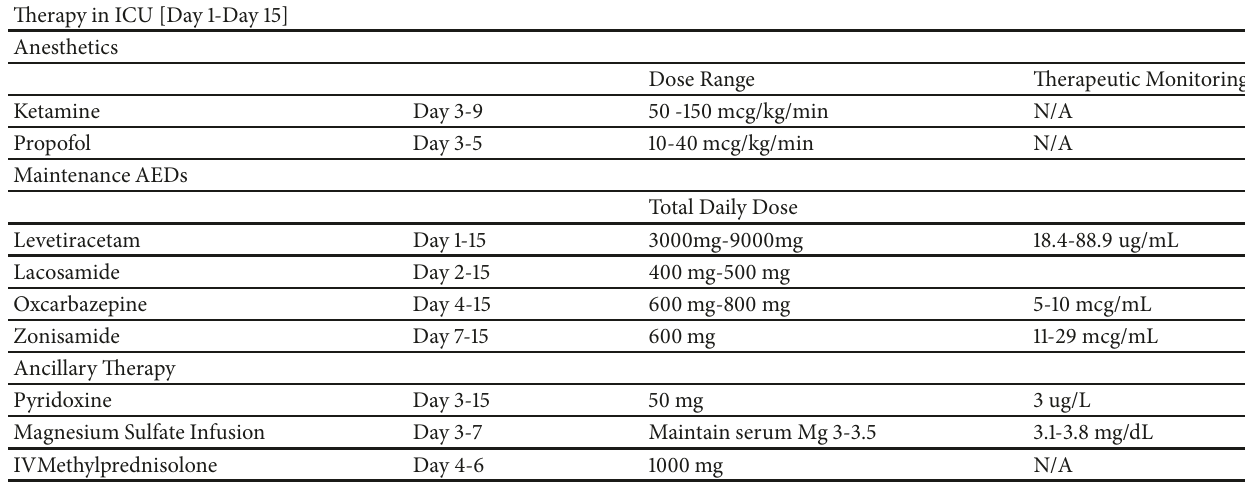
Table 1: “The timeline of different antiepileptic medications during ICU